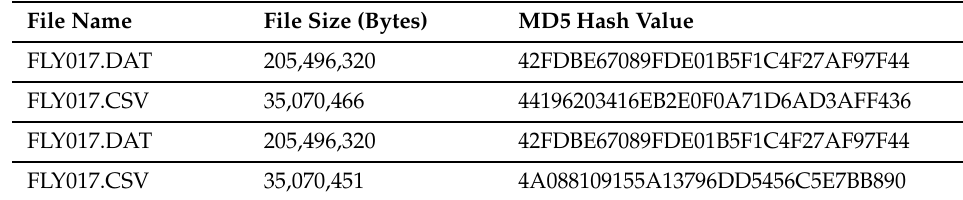
Table 5. A checksum analysis to evaluate UAV digital evidence integrity.